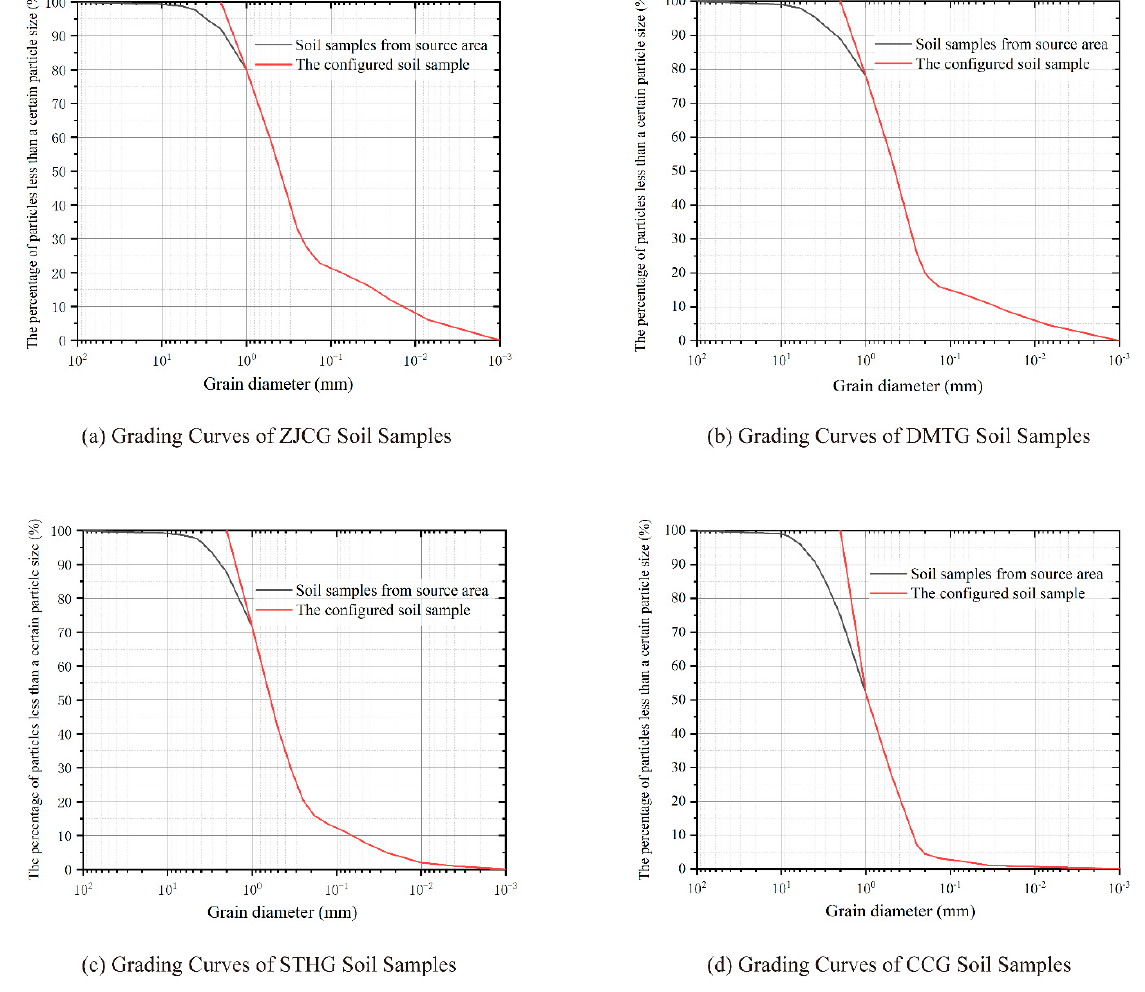
Figure 8. Gradation curves of test soil samples.